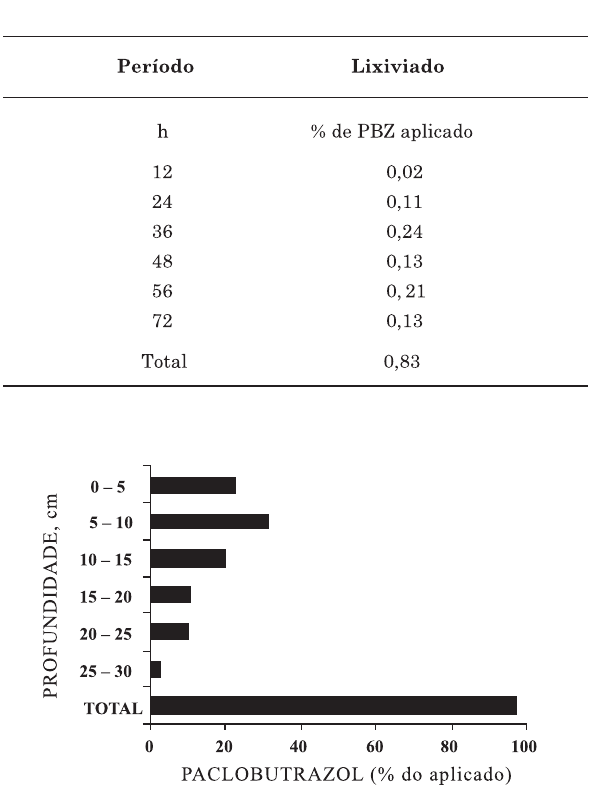
Figura 2. Mobilidade do paclobutrazol no perfil da coluna de solo (% do